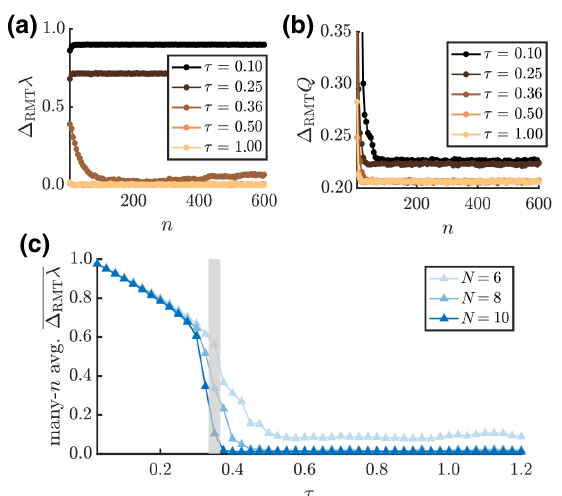
FIG. 9. Convergence of λ 1 and Q to RMT prediction. Devia- tion of λ 1 (a) and Q (b) from the respective RMT estimates, as a function of the number of cycles n , for different values of τ below (black and brown) and above (orange and yellow) the Trotter threshold, for a system of N = 10 spins. (c) Long-time average of λ as a function of τ . The vertical shaded gray line marks the (cid:11) RMT Trotter threshold. Beyond the Trotter threshold (cid:11) RMT λ is small, indicating the agreement with the corresponding RMT predic- tion. The results are obtained for the Trotterized XXZ -Heisenberg = 0.9, J y = 1.5, J z = 0.5, B x = 0.65, B y = 0.3, model with J x j j j j j = 0.45. In these plots we set n → ∞ , and use 1000 initial B z s j states in random